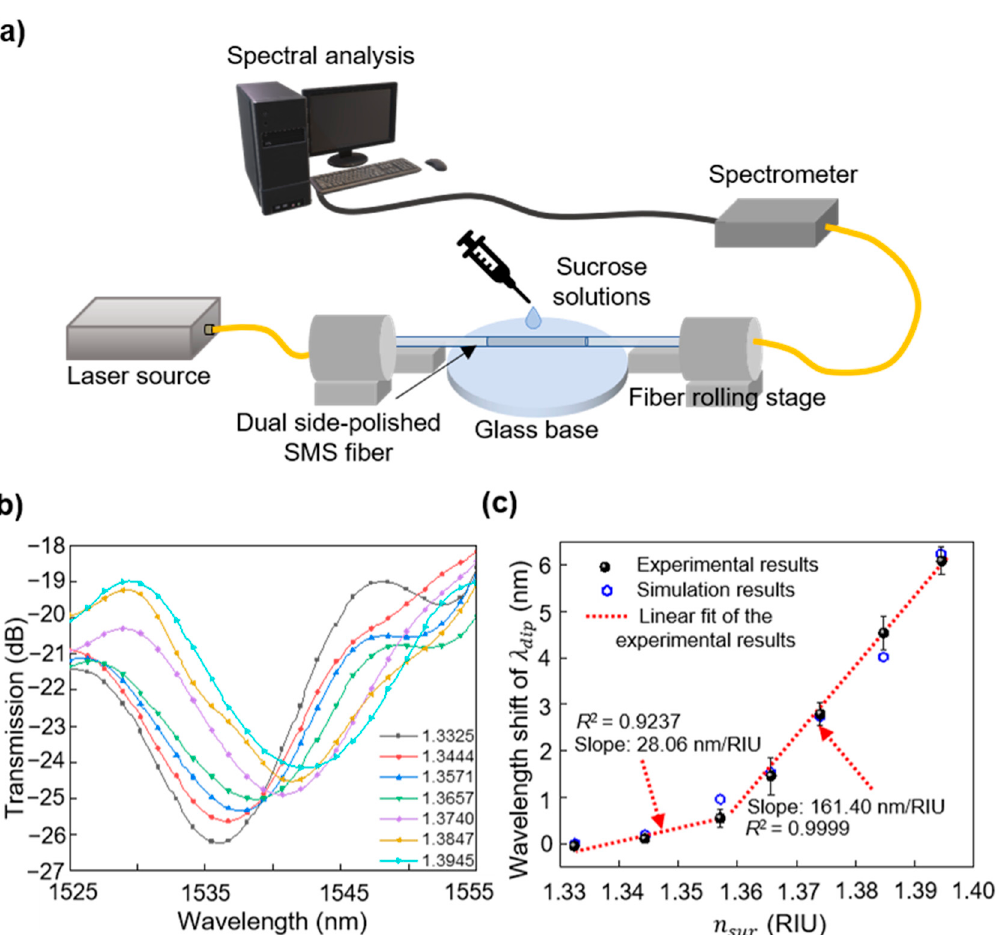
Figure 7. ( a ) Experimental setup of the fs ‐ laser polished SMS fiber for sensing surrounding RI. ( b ) Meas ‐ ured transmitted spectra of the dual ‐ side polished SMS fiber when 1.3325 < 𝑛 (cid:3046)(cid:3048)(cid:3045) < 1.3945. ( c ) Meas ‐ ured and calculated dependence of the wavelength shift of 𝜆 (cid:3031)(cid:3036)(cid:3043) on 𝑛 (cid:3046)(cid:3048)(cid:3045) .